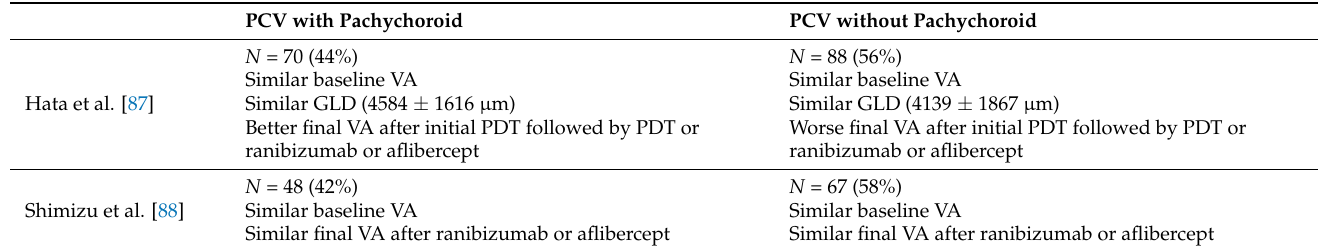
Table 10. Treatment response of PCV with pachychoroid and PCV without